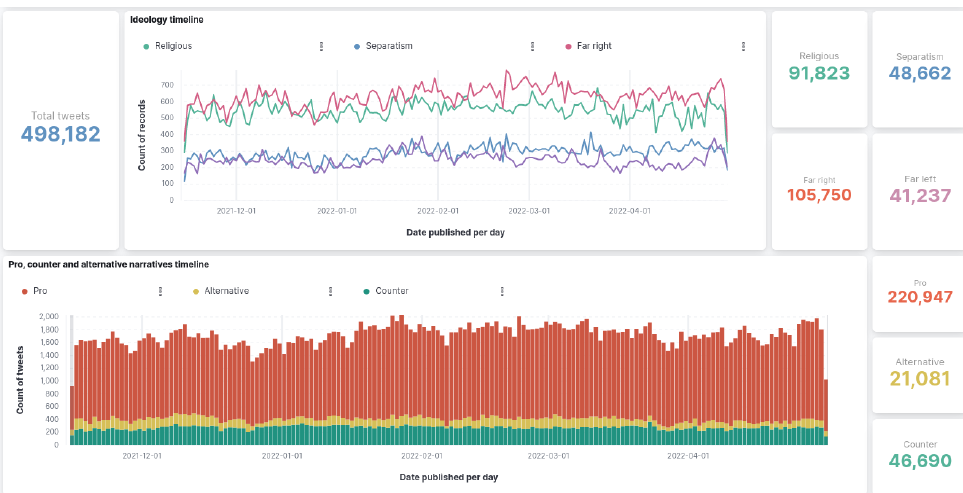
Figure 8. Overview of the interface. Part I. Time